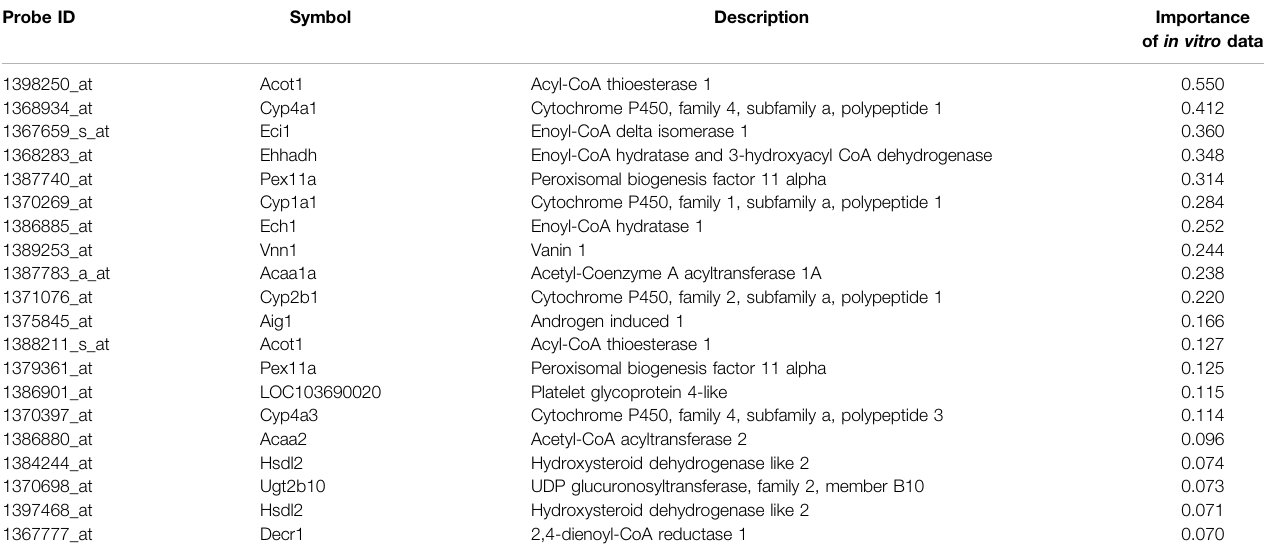
TABLE 3 | List of top 20 genes with high importance in vitro data in the predictive models in